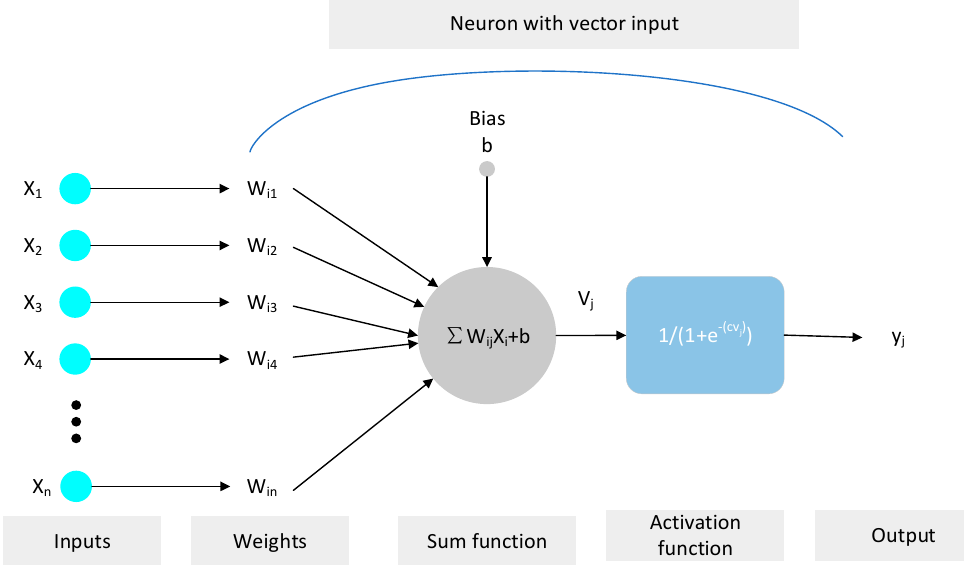
Figure 16. Information processing process of a single hidden layer neuron.